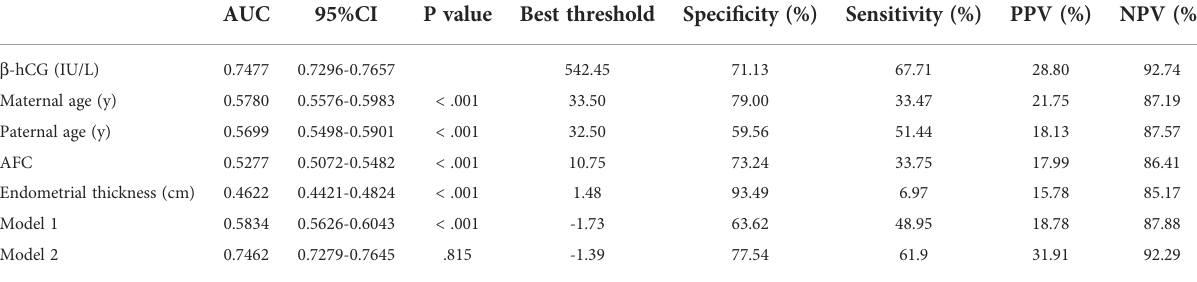
TABLE 4 Accuracy of different variables and models in IVF/ICSI clinic pregnancy to predict early pregnancy loss. AUC